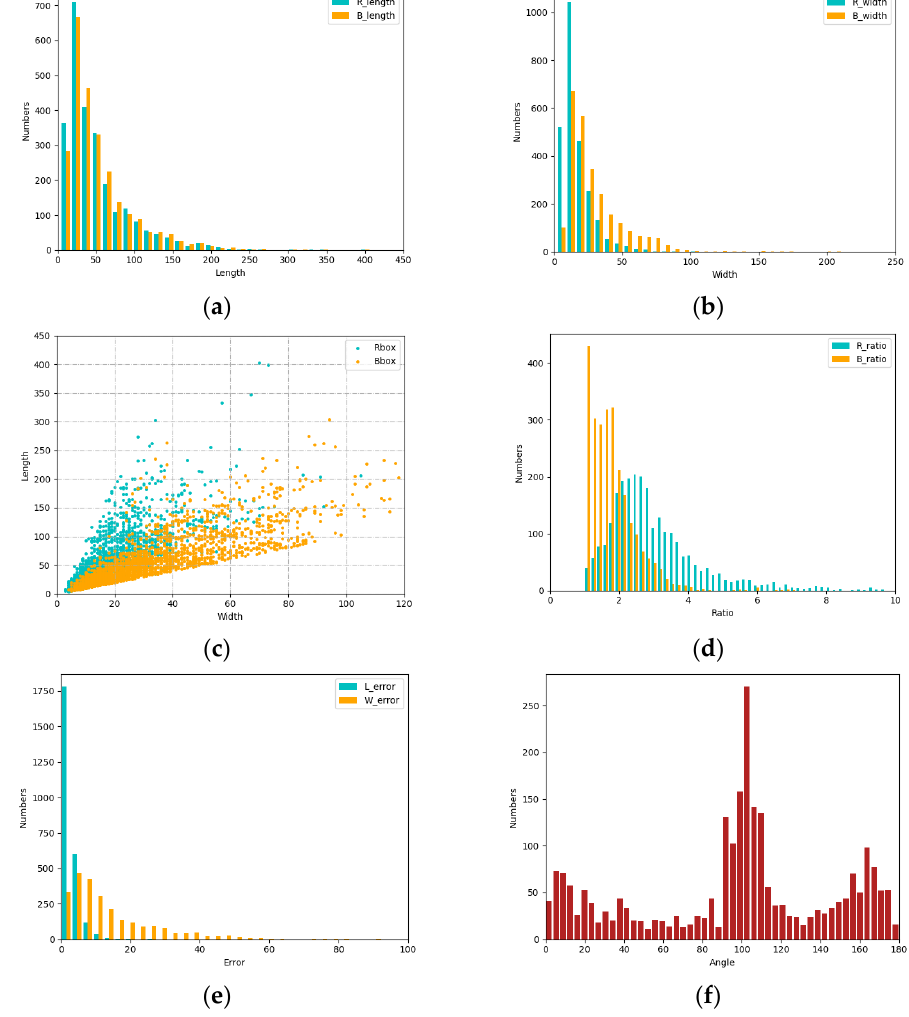
Figure 6. The distributions of the sizes, aspect ratios, angle and corresponding error of the horizontal bounding boxes and oriented bounding boxes in SSDD. ( a ) Distributions of the bounding boxes’ length in SSDD. ( b ) Distributions of the bounding boxes’ width in SSDD. ( c ) Distributions of the bounding boxes’ sizes in SSDD. ( d ) Distributions of the bounding boxes’ aspect ratios in SSDD. ( e ) Distributions of corresponding errors of the HBB and OBB in SSDD. ( f ) Distributions of the oriented bounding boxes’ angle in SSDD. Table 3. Division of different datasets.